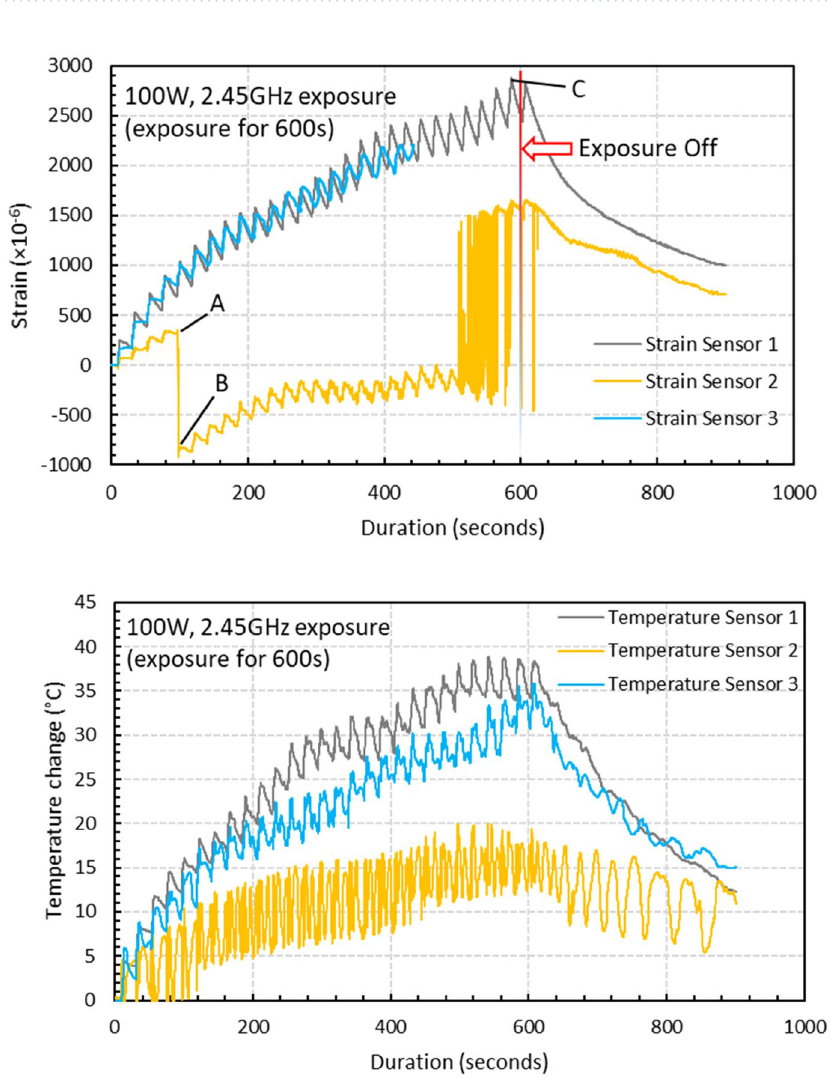
Figure 19. Strain and temperature change measurements of 15 wt.% silane-treated BaTiO 3 -Epoxy samples under 100 W for 600